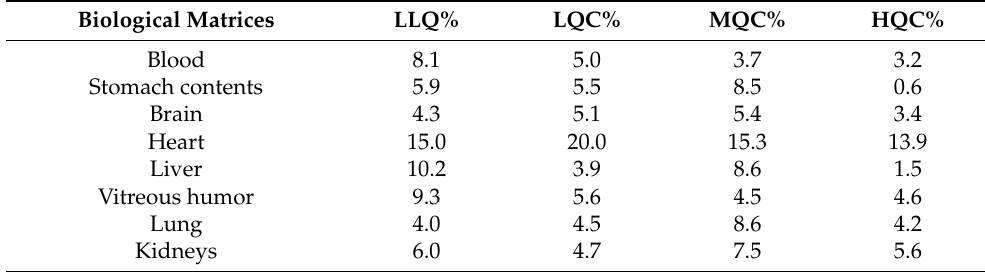
Table 2. Precision in each matrix for aldicarb was evaluated by means of the coefficient of variation (CV%) of lower limit of quantification (LLQ), low-quality control (LQC), medium-quality control (MQC), and high-quality control